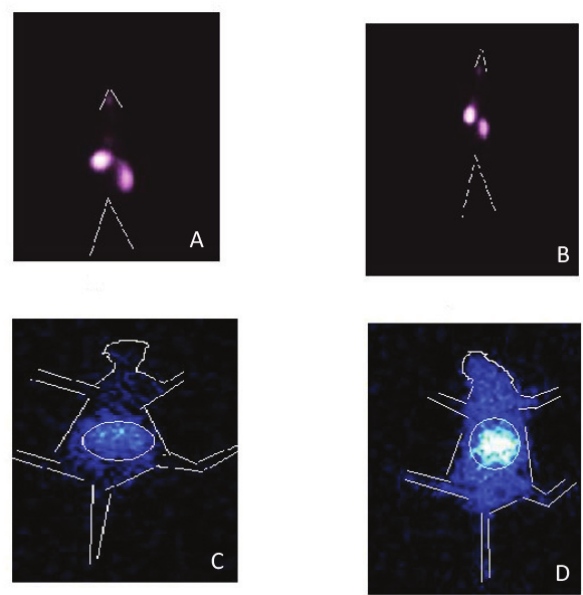
Figure 1. Organ distribution of Tc99m isotope labeled deoxynivalenol. ( A ) Photomicrograph at three hours after oral dosing. ( B ) Photomicrograph eight hours after oral dosing. ( C ) Photomicrograph 26 hours after oral dosing. ( D ) Photomicrograph 26 hours after IV dosing.